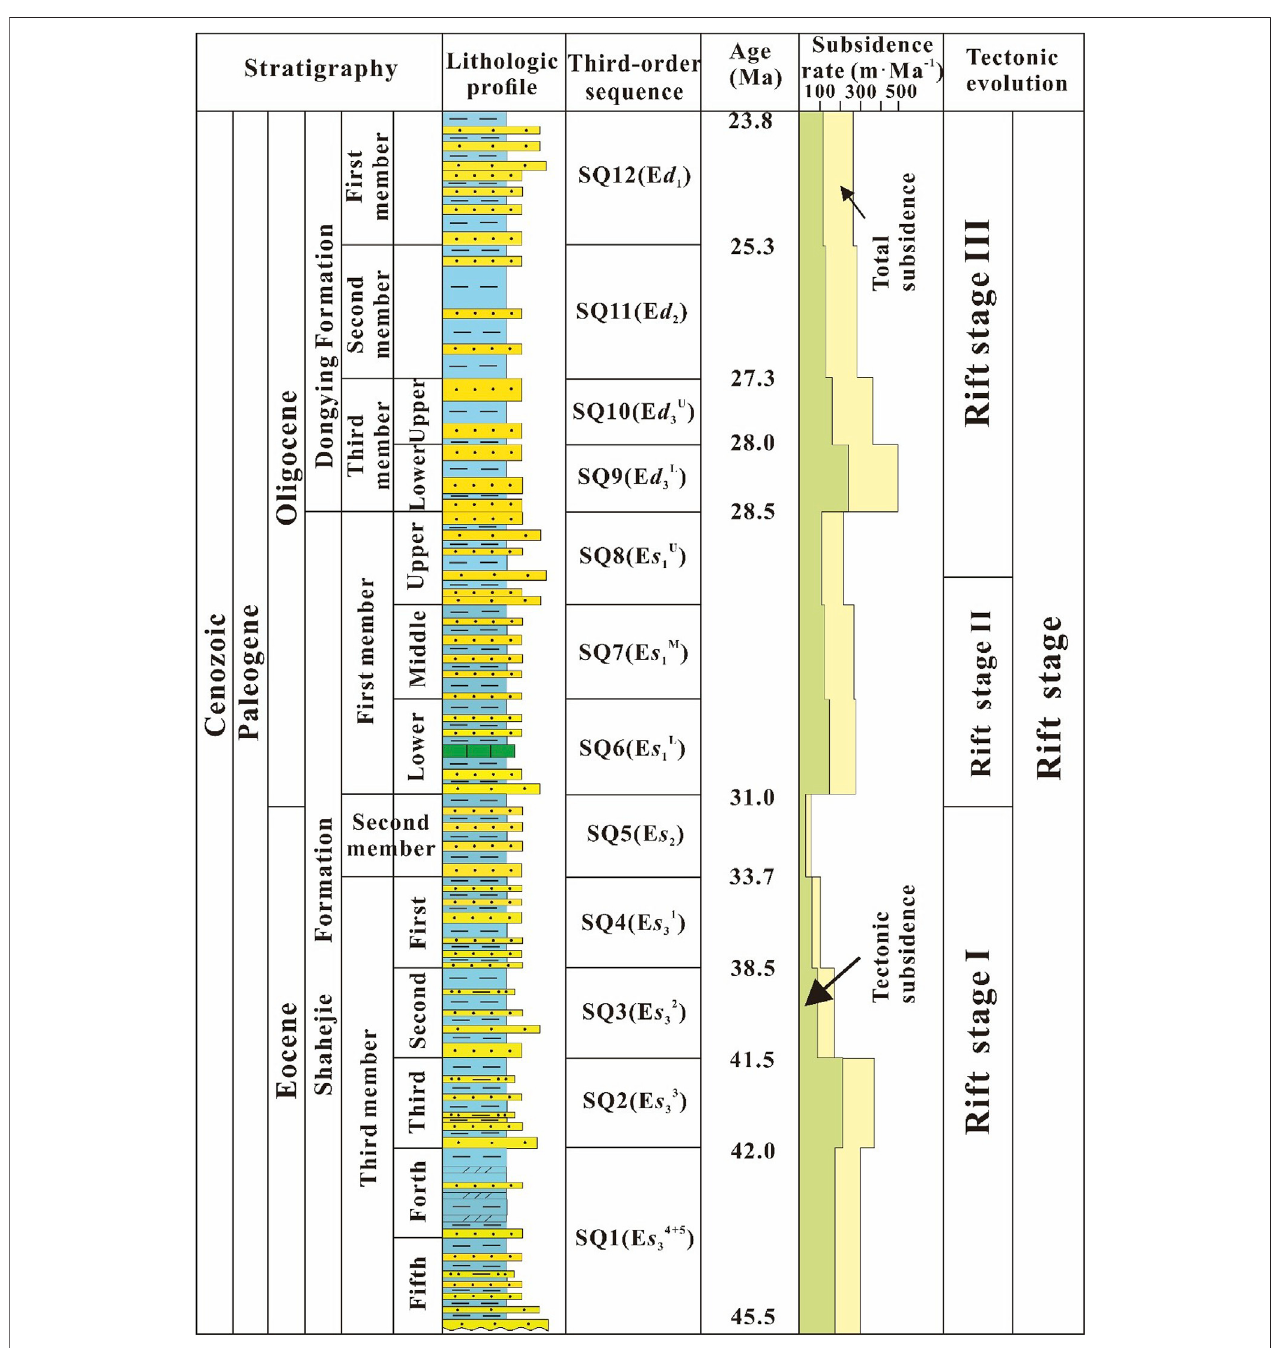
FIGURE 2 | Stratigraphic nomenclature for the Paleogene of Nanpu Sag (Modi fi ed from Wang et al., 2011).